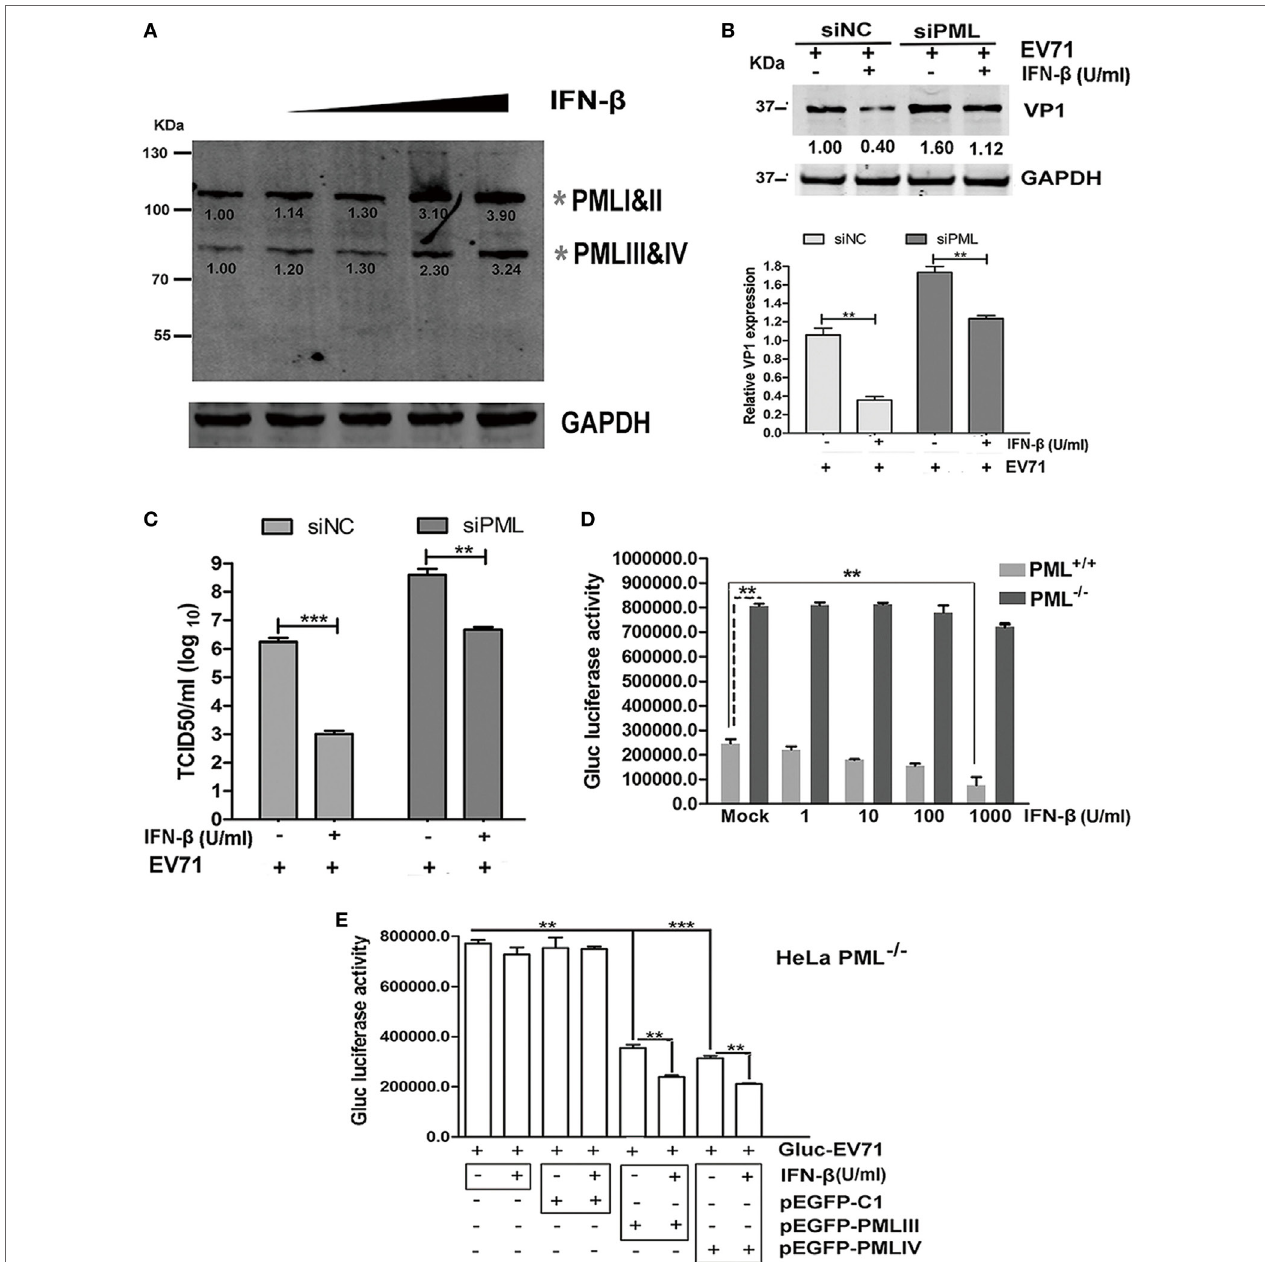
FigUre 5 | Antiviral activity of interferon (IFN)- β required the presence of promyelocytic leukemia (PML). (a) HeLa cells were treated with IFN- β at various concentrations (10–1,000 U/ml) for 24 h, and the endogenous PML isoforms were detected by performing a Western blot analysis. The gray asterisks indicate PML isoforms I and II or PMLIII and IV. (B,c) HeLa cells were transfected with siNC or siPML for 24 h, and the siNC- or siPML-treated cells were treated with or without IFN- β (1 × 10 3 U/ml) for 12 h and then infected with Gluc-enterovirus 71 (EV71) at an multiplicity of infection (MOI) of 5 for 24 h. The cell lysates were analyzed by performing a Western blot analysis using antibodies against VP1 and GAPDH. The density of the bands was scanned by performing densitometry and normalized to that of GAPDH. The VP1 value in the cells treated with siNC and infected with EV71 without IFN- β treatment is set as 1.00 (B) . The culture supernatants were measured by performing a TCID 50 assay using Vero cells (c) . Three independent experiments were performed, and representative data are shown. (D) PML + / + and PML − / − cells were treated with IFN- β at various concentrations for 24 h and mock-infected or infected with Gluc-EV71 (MOI = 1) for 48 h, and the virus supernatants were measured by performing a luciferase activity assay. The presented values are the mean of triplicate determinations and SEM. Three independent experiments were performed, and representative data are shown. Asterisks indicate significant differences (** p < 0.01). (e) PML + / + and PML − / − cells were treated with IFN- β at 1 × 10 3 U/ml for 24 h and transfected with pEGFP-C1, pEGFP-PMLIII, or pEGFP-PMLIV for 24 h. Then, the cells were infected with Gluc-EV71 at an MOI of 1 for 48 h, and the culture supernatants were measured by performing a luciferase activity assay. The presented values are the means of triplicate determinations and SEM. Three independent experiments were performed, and representative data are shown. The asterisks indicate significant differences (*** p < 0.001, ** p <